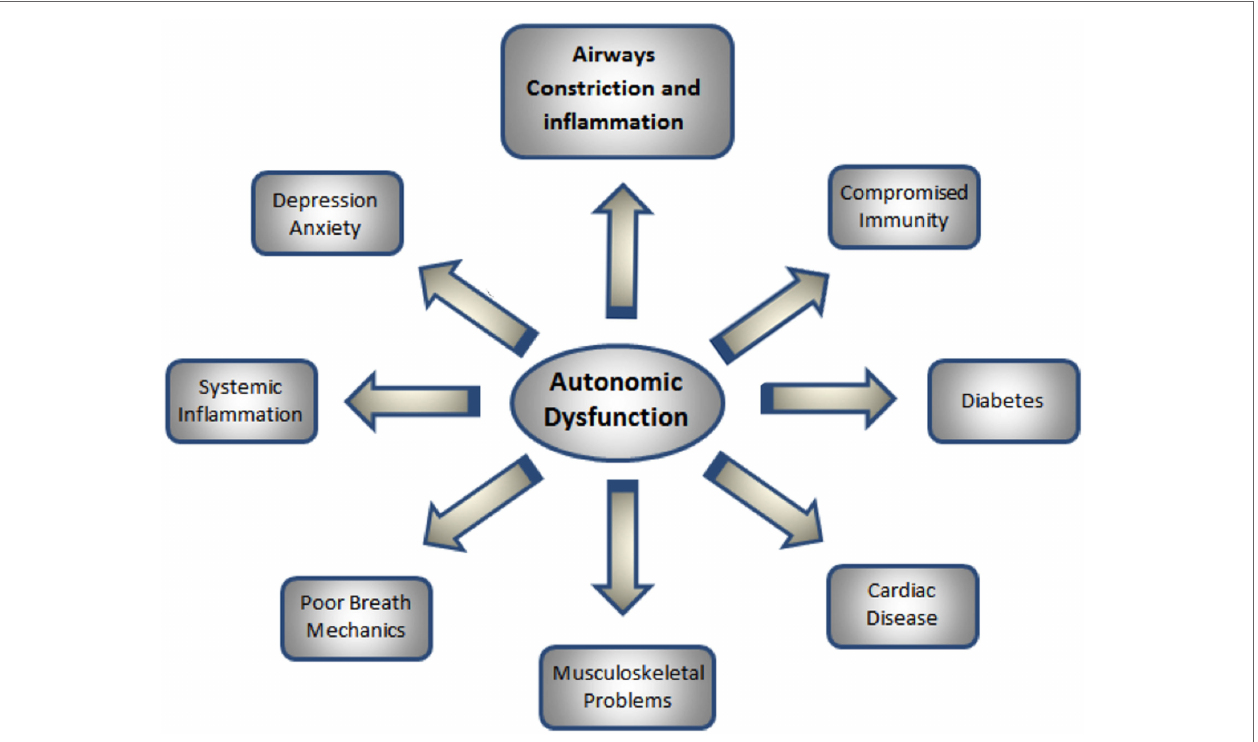
FIGUrE 2 | relationships of autonomic dysfunction to the co-morbidities of coPD